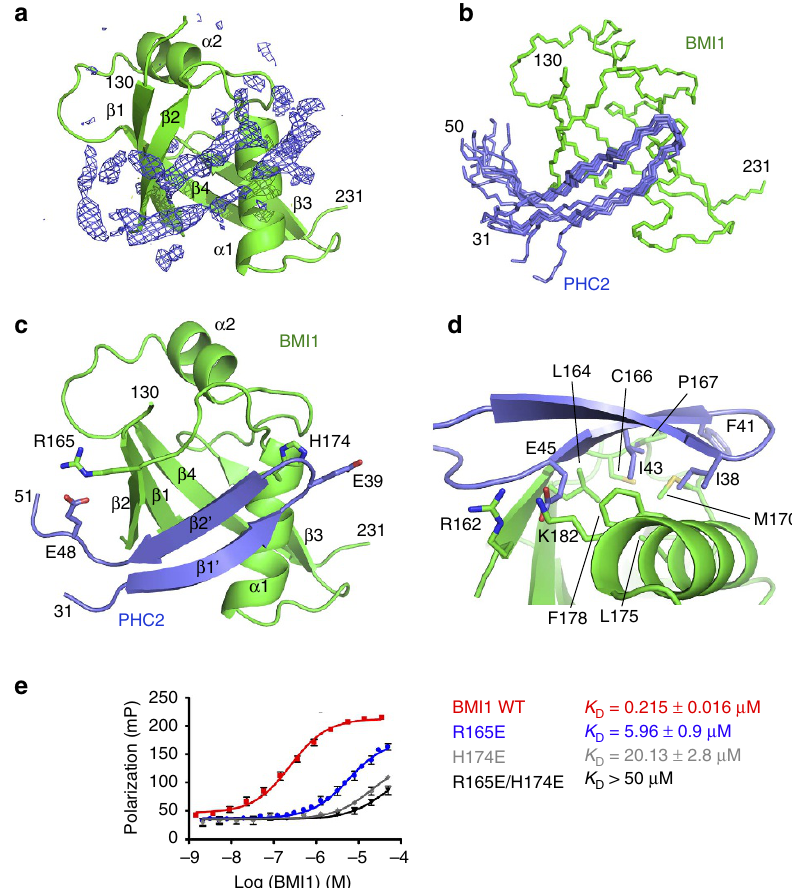
Figure 2 | Structure of the PHC2–BMI1 complex. ( a ) Crystal structure of the BMI1 UBL domain with Fo-Fc electron density map showing unmodelled density (blue). ( b ) Ten lowest energy structures of the PHC2–BMI1 complex determined using joint refinement employing NMR and X-ray data. The backbone of BMI1 residues 130–231 is shown in green and PHC2 residues 31–50 are shown in blue. Unstructured residues are omitted for clarity. ( c ) The overall structure of the PHC2–BMI1 complex using ribbon representation. Side chains of residues mutated to disrupt the PHC2–BMI1 interaction are shown in sticks. ( d ) Details of the PHC2–BMI1 interface. ( e ) Binding affinities of PHC2 with BMI1 variants determined using fluorescence polarization (FP) experiments titrating FITC–PHC2 32–61 with wild-type BMI1 UBL or point mutants. Experiments were performed in duplicates, error bars represent s.d.; K D is reported as an average and s.d. from three independent